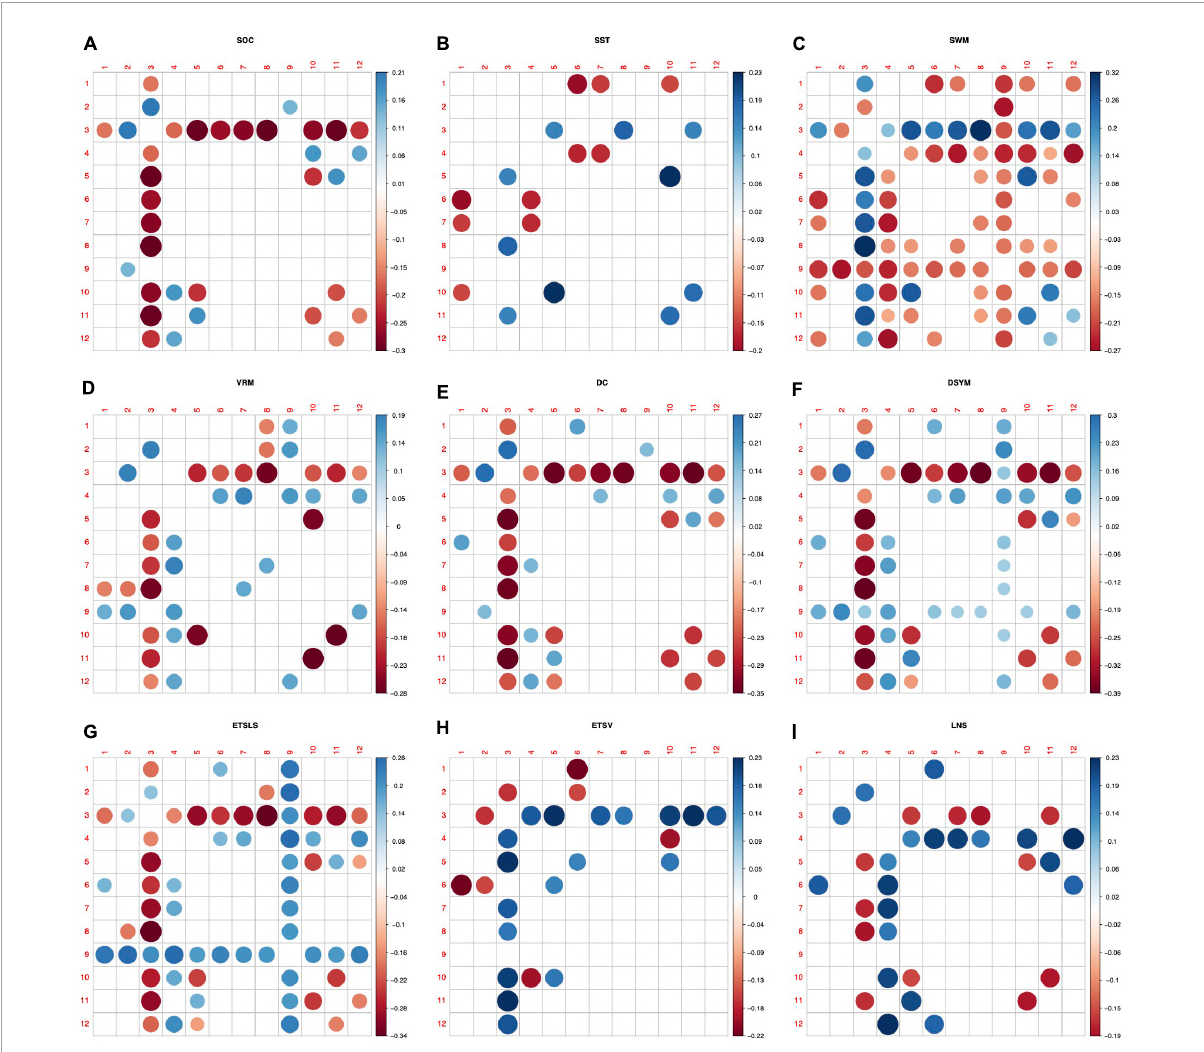
FIGURE5 Predictive patterns of the white matter structural covariance connectivity. (A–I) Denote the nine cognitive tasks. The nine cognitive predictive patterns are related to the Stockings of Cambridge (SOC), the stop signal task (SST), the spatial working memory (SWM), the verbal recognition memory (VRM), the digit comparison (DC), the digit symbol (DSYM), the ETS advanced vocabulary (ETSV), the ETS letter sets (ETSLS), and letter number sequencing (LNS), respectively. Red circles denote negative correlations to cognitive scores. Blue circles denote positive correlations to cognitive